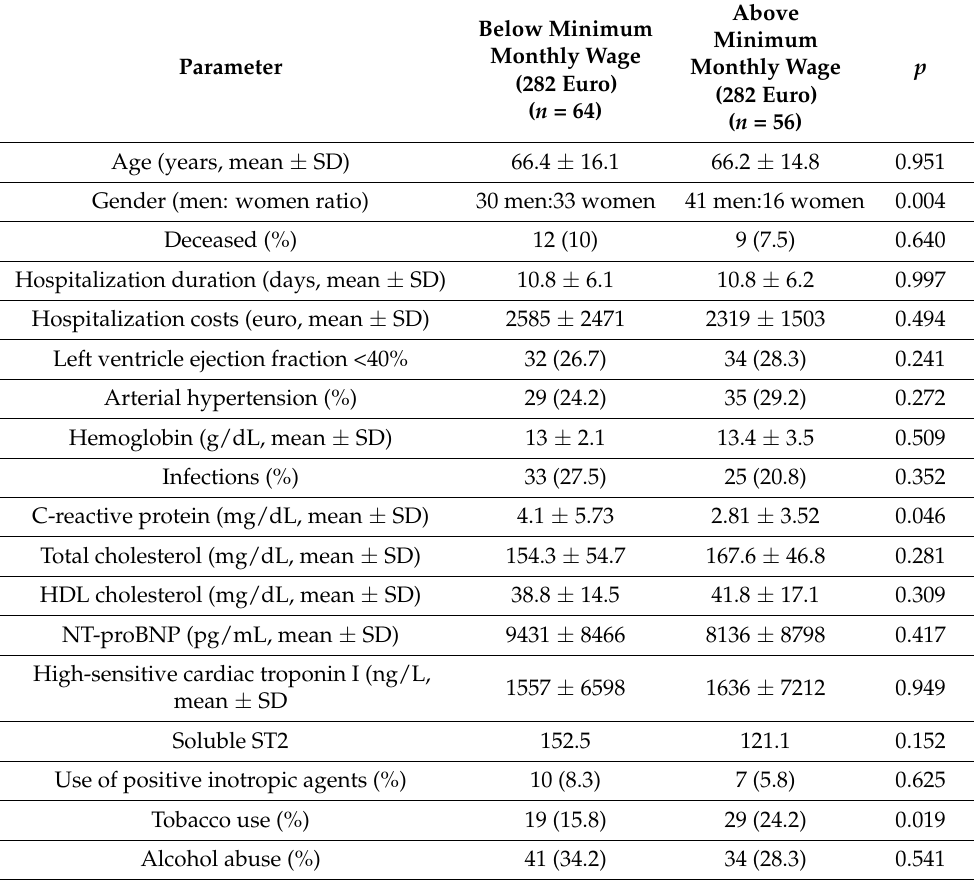
Table 3. Influence of poor economic status on certain clinical and biological parameters in patients with HF. Parameter